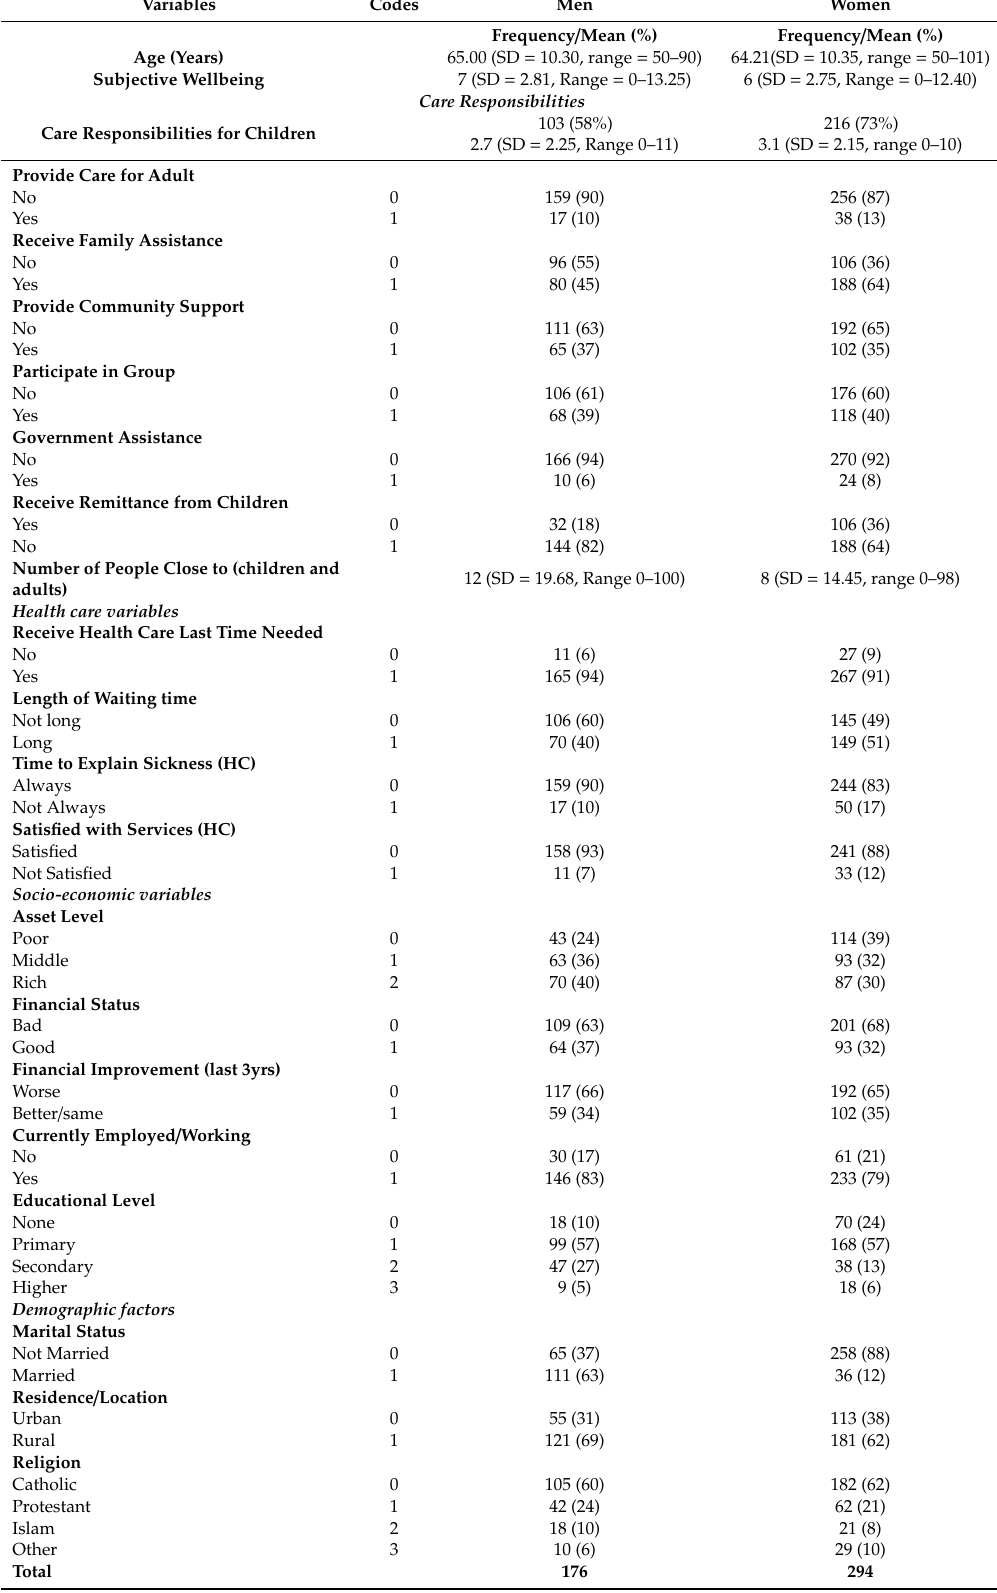
Table 1. Descriptive statistics of selected variables. SD = standard